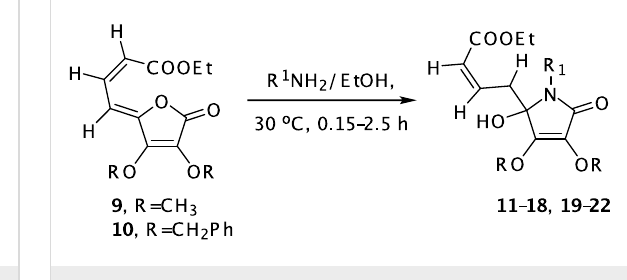
Figure 2: H-bonding in tetronolactonyl dienyl esters.